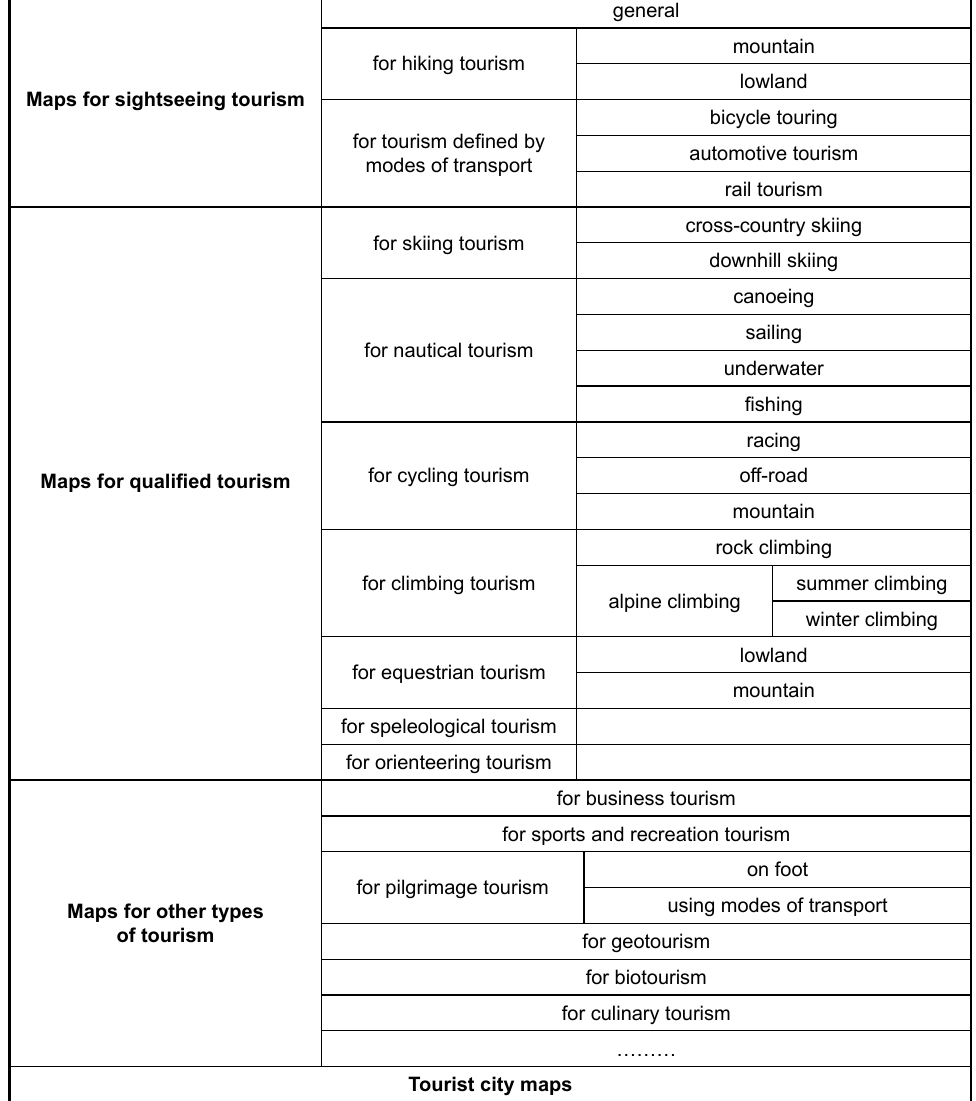
Maps for sightseeing